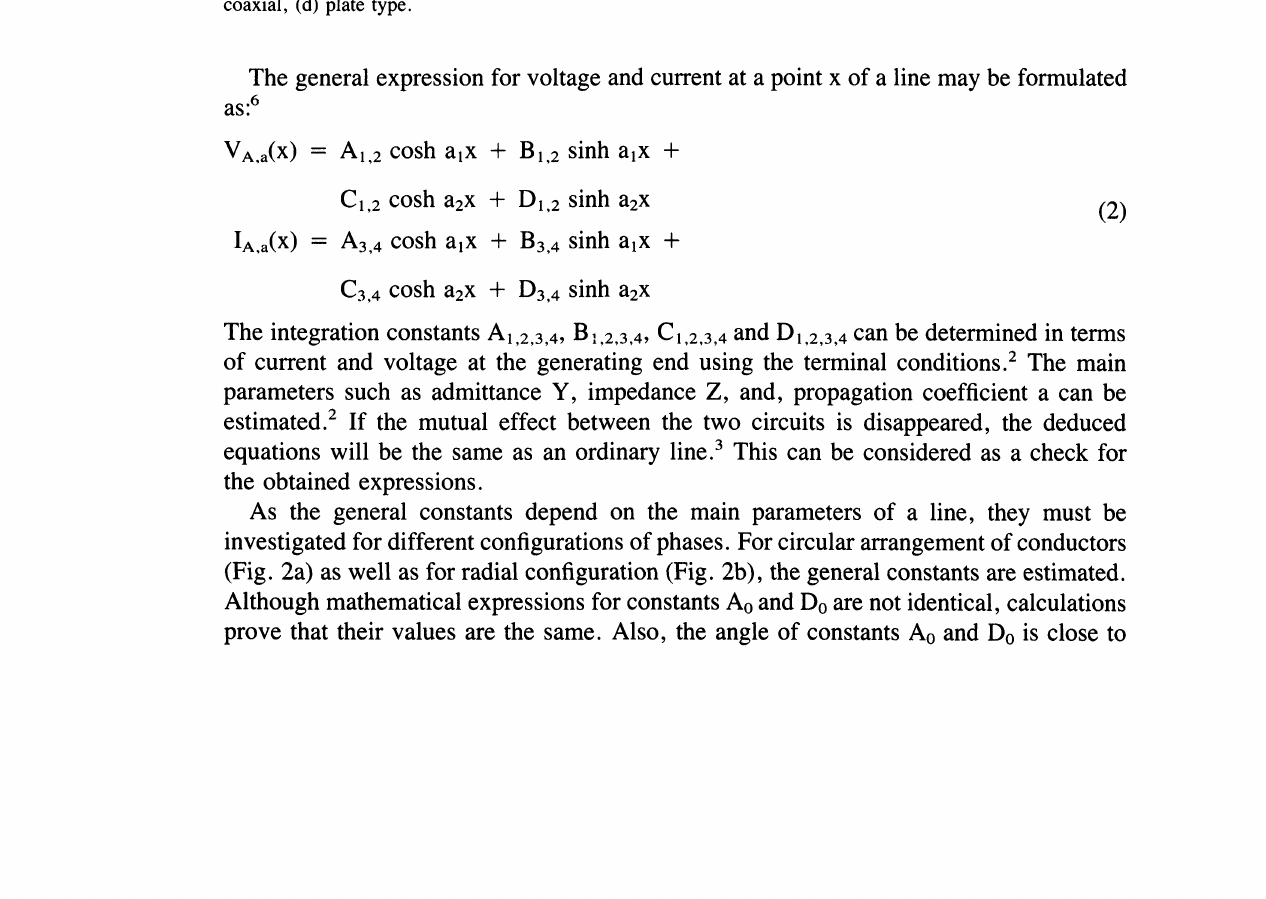
FIGURE 2 Different configurations for conductors of phases of the proposed line: (a) circular, (b) radial, (c) coaxial, (d) plate